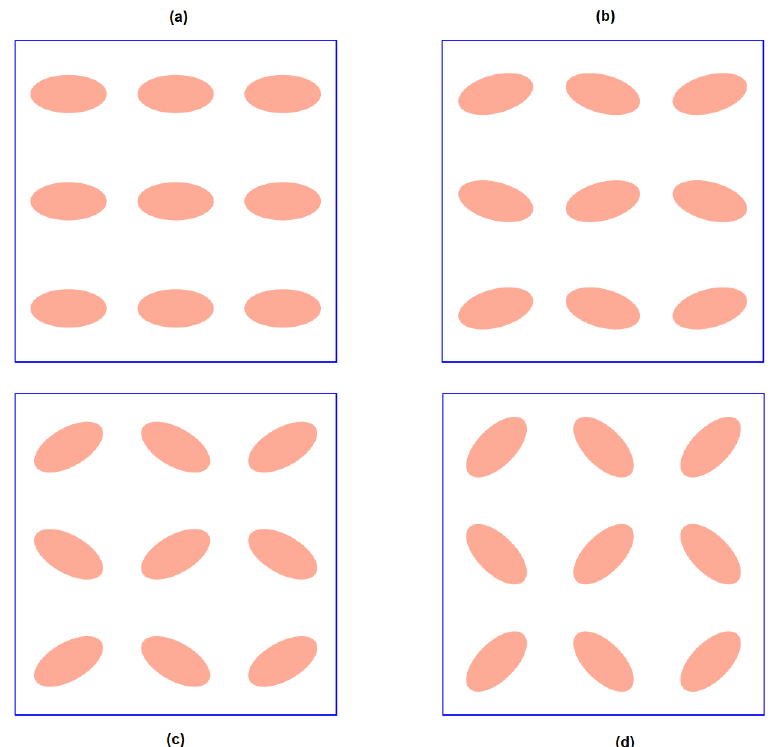
Figure 11. Fiber distribution in the cell quarter, ( a ) θ = 0 ◦ alignment (equally aligned), ( b ) θ = 15 ◦ alignment, ( c ) θ = 30 ◦ alignment, ( d ) θ = 45 ◦ alignment.